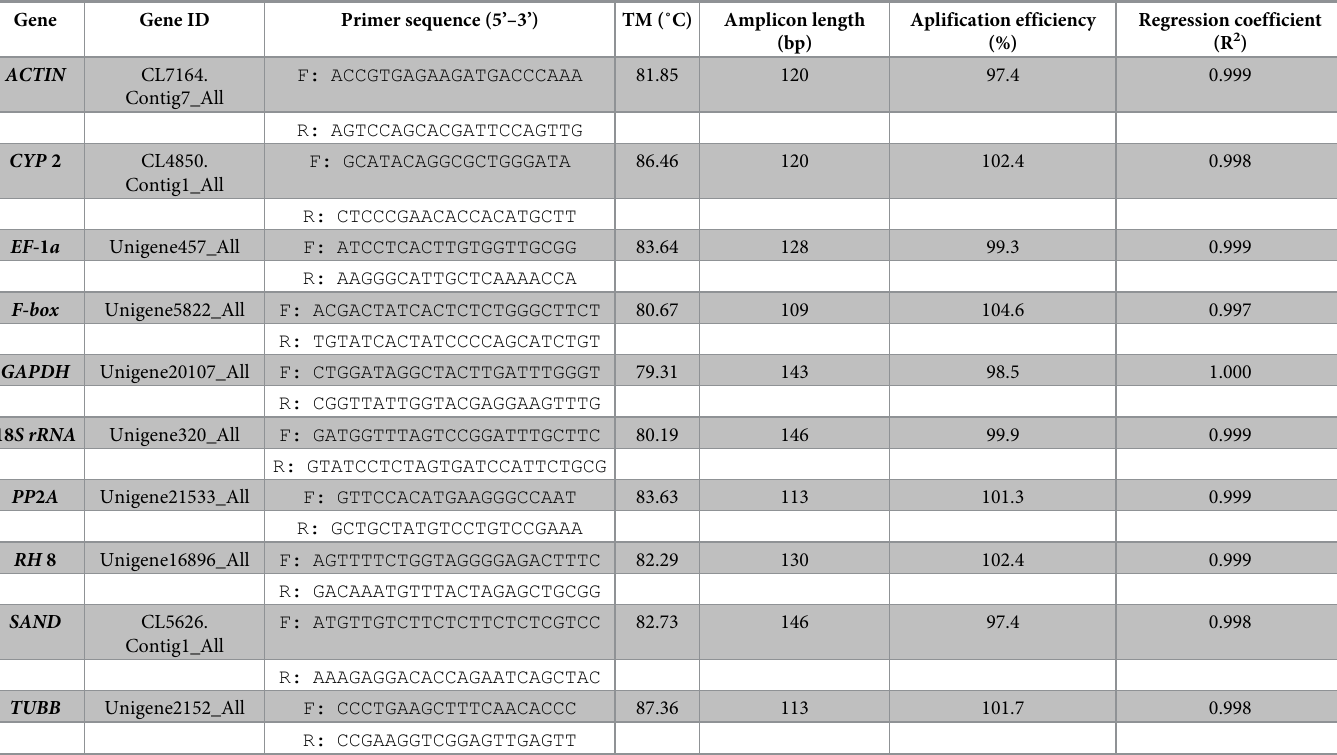
Table 2. Genes for primer design were screened in each candidate gene family.